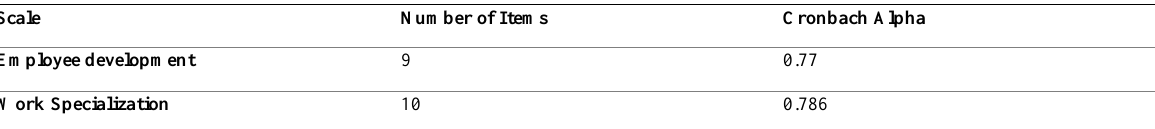
Table 1: Cronbach Alpha Results